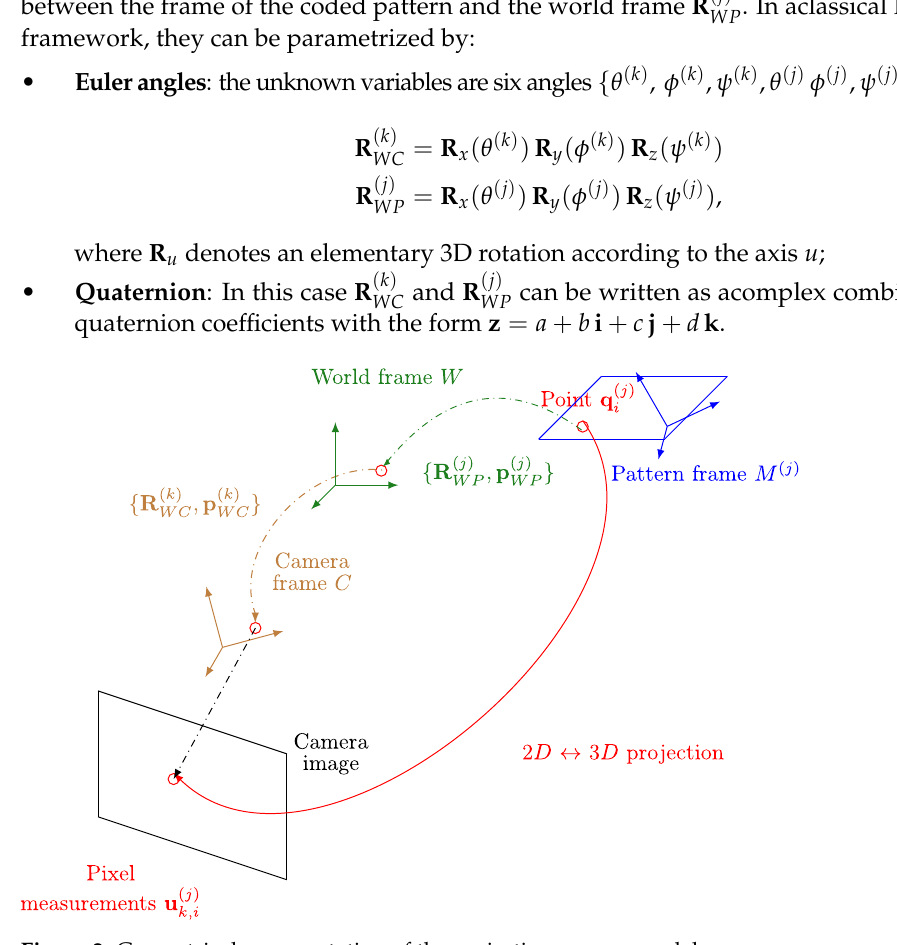
Figure 2. Geometrical representation of the projection camera